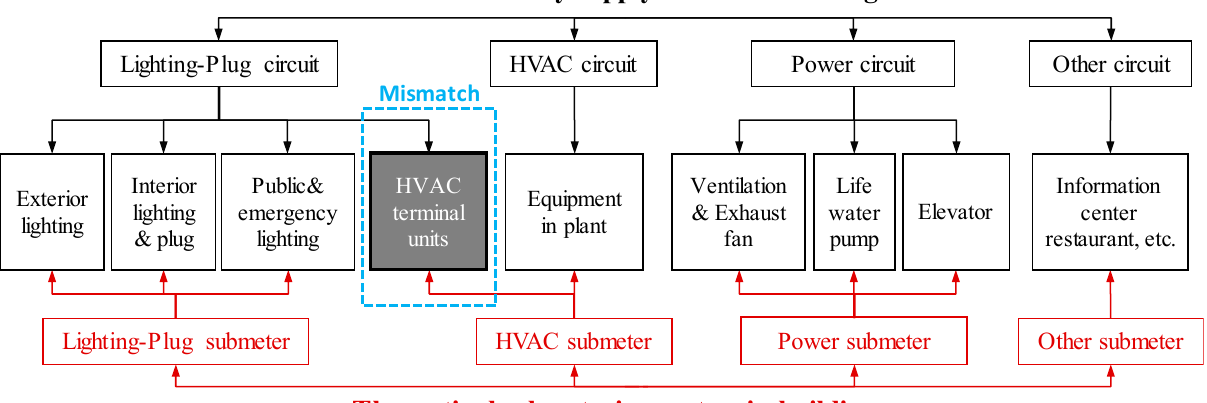
Figure 1. Structure of a sub-metering system and the gap between an actual model and the theoretical classification model.